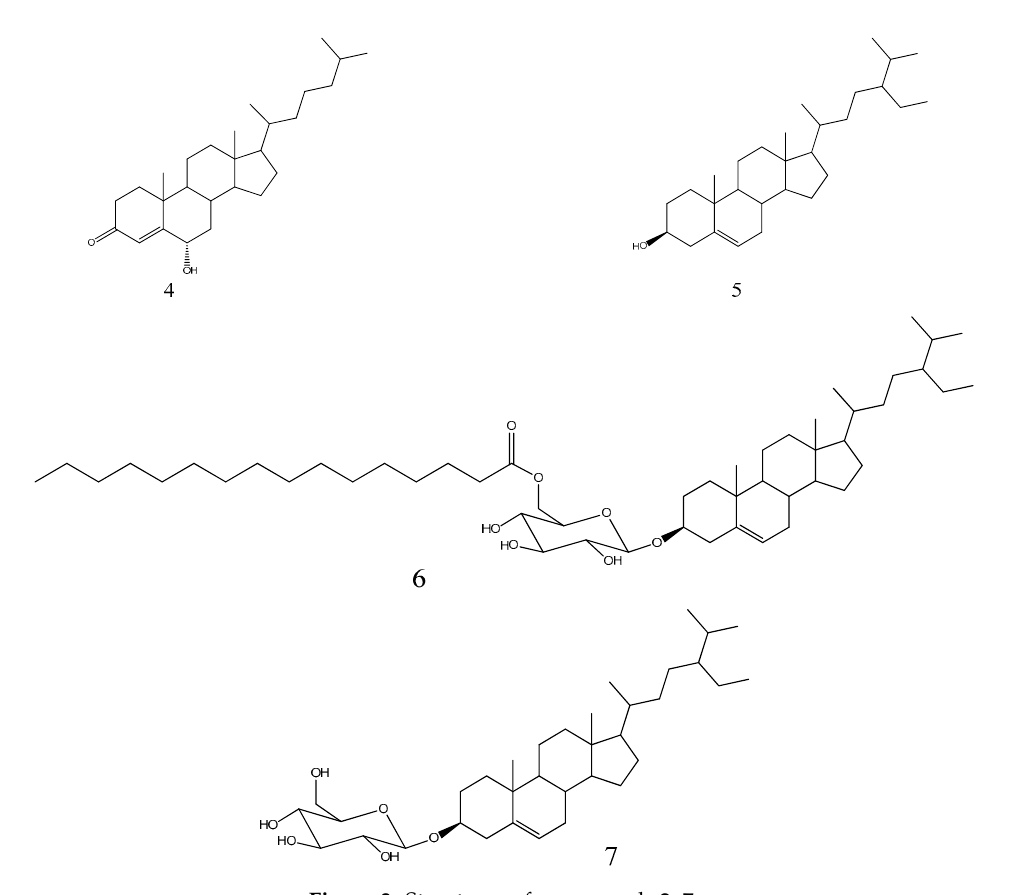
Figure 3. Structures of compounds 2 – 7.